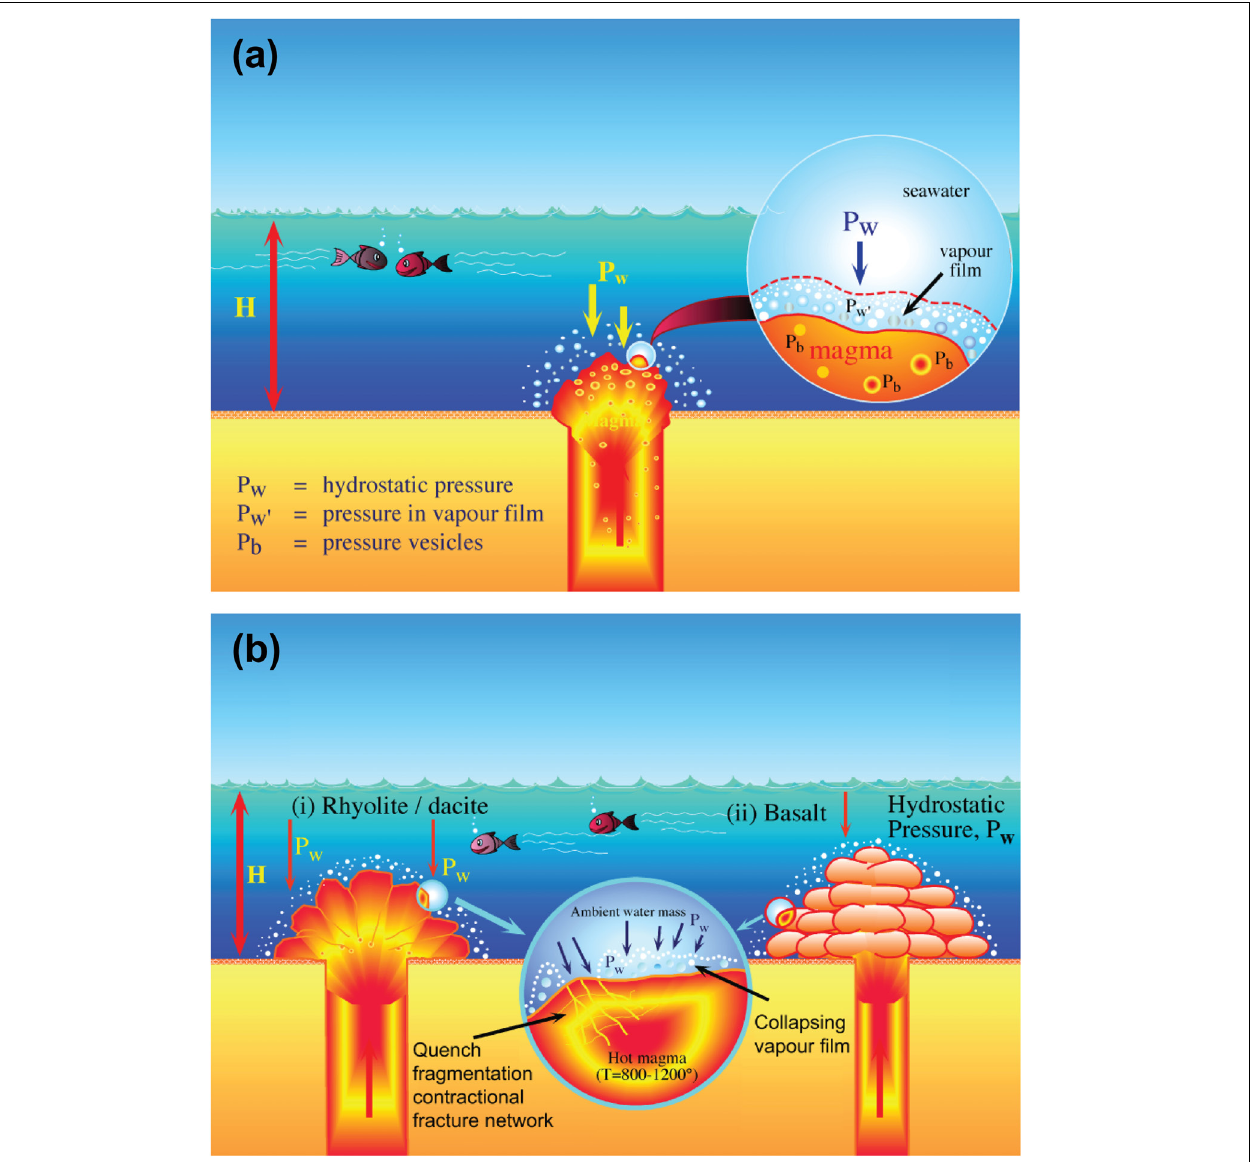
FIGURE 6 | Film boiling at the interface between hot magma and a body of water. (a) Stable film boiling at the interface, leading to controlled heat lost across the vapor film and formation of a visco-elastic and progressively a coherent crust to the lava flow. (b) Vapor film collapse, leading to in situ rapid cooling of the magma at the interface through the glass transition, and rapid cooling contraction fracturing of the glass into an in situ , jigsaw-fit breccia.